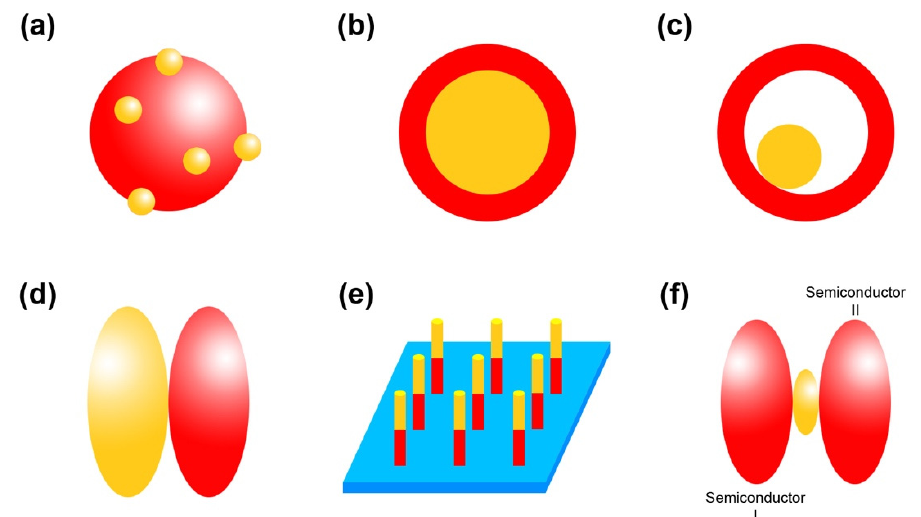
Figure 4. ( a ) Conventional structure; ( b ) Core-shell structure; ( c ) Yolk-shell structure; ( d ) Janus structure; ( e ) Array structure; ( f ) Multi-junction structure.